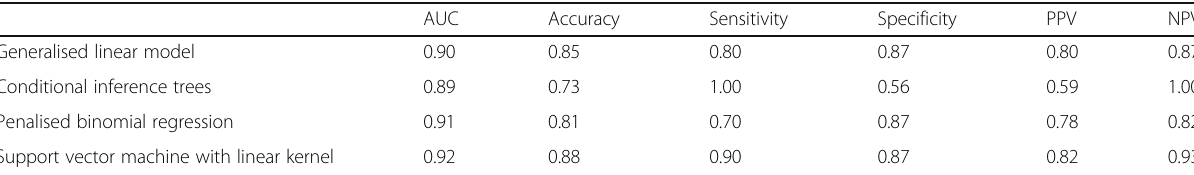
Table 3 Overall model